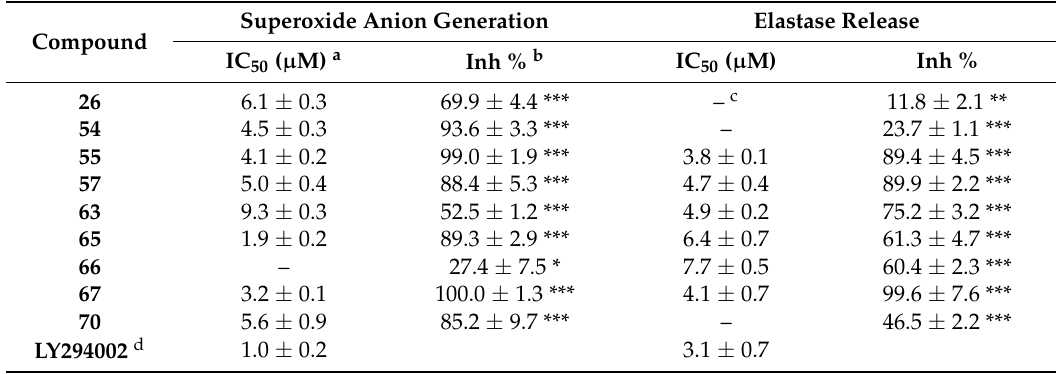
Table 2. Inhibitory effects of purified compounds on superoxide anion generation and elastase release by human neutrophils in response to